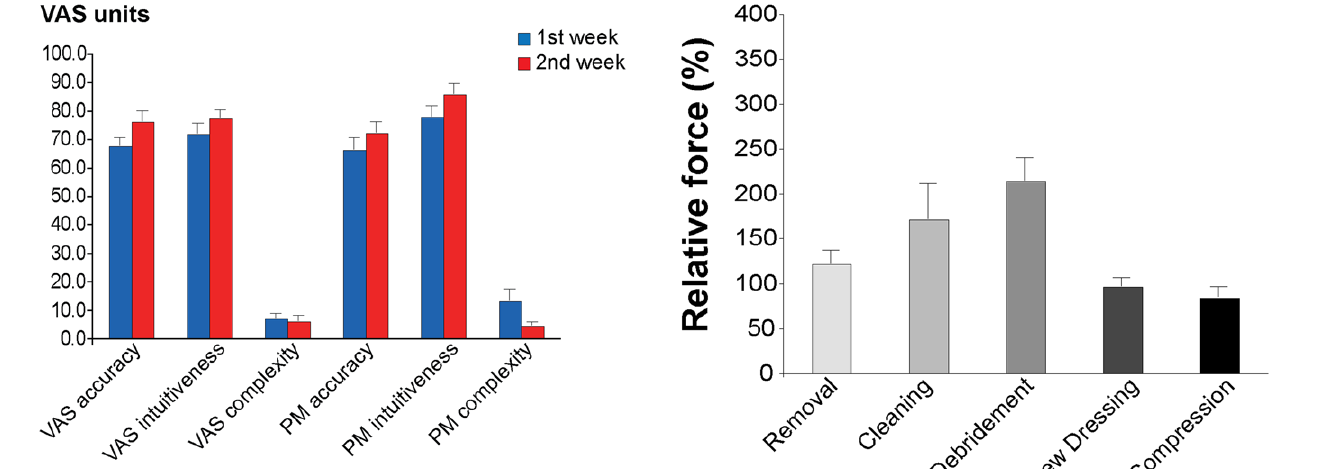
Figure 3. Mean complexity, accuracy and intuitiveness ratings of the VAS and the PM. There was no significant difference between the two methods or between ratings of the first and second week. However, there was a trend to rate the PM-method as being more intuitive. Bars depict average values and their S.E.